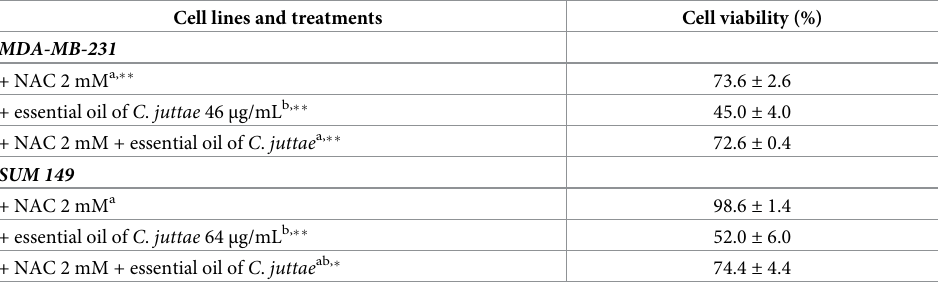
Table 2. Results of cell counting analysis in the two cell lines following treatment with antioxidant N-acetyl-L-cys- teine (NAC) at 2mM before exposure to the essential oil at the corresponding IC 50 . Data are expressed as mean ± standard error (SE).